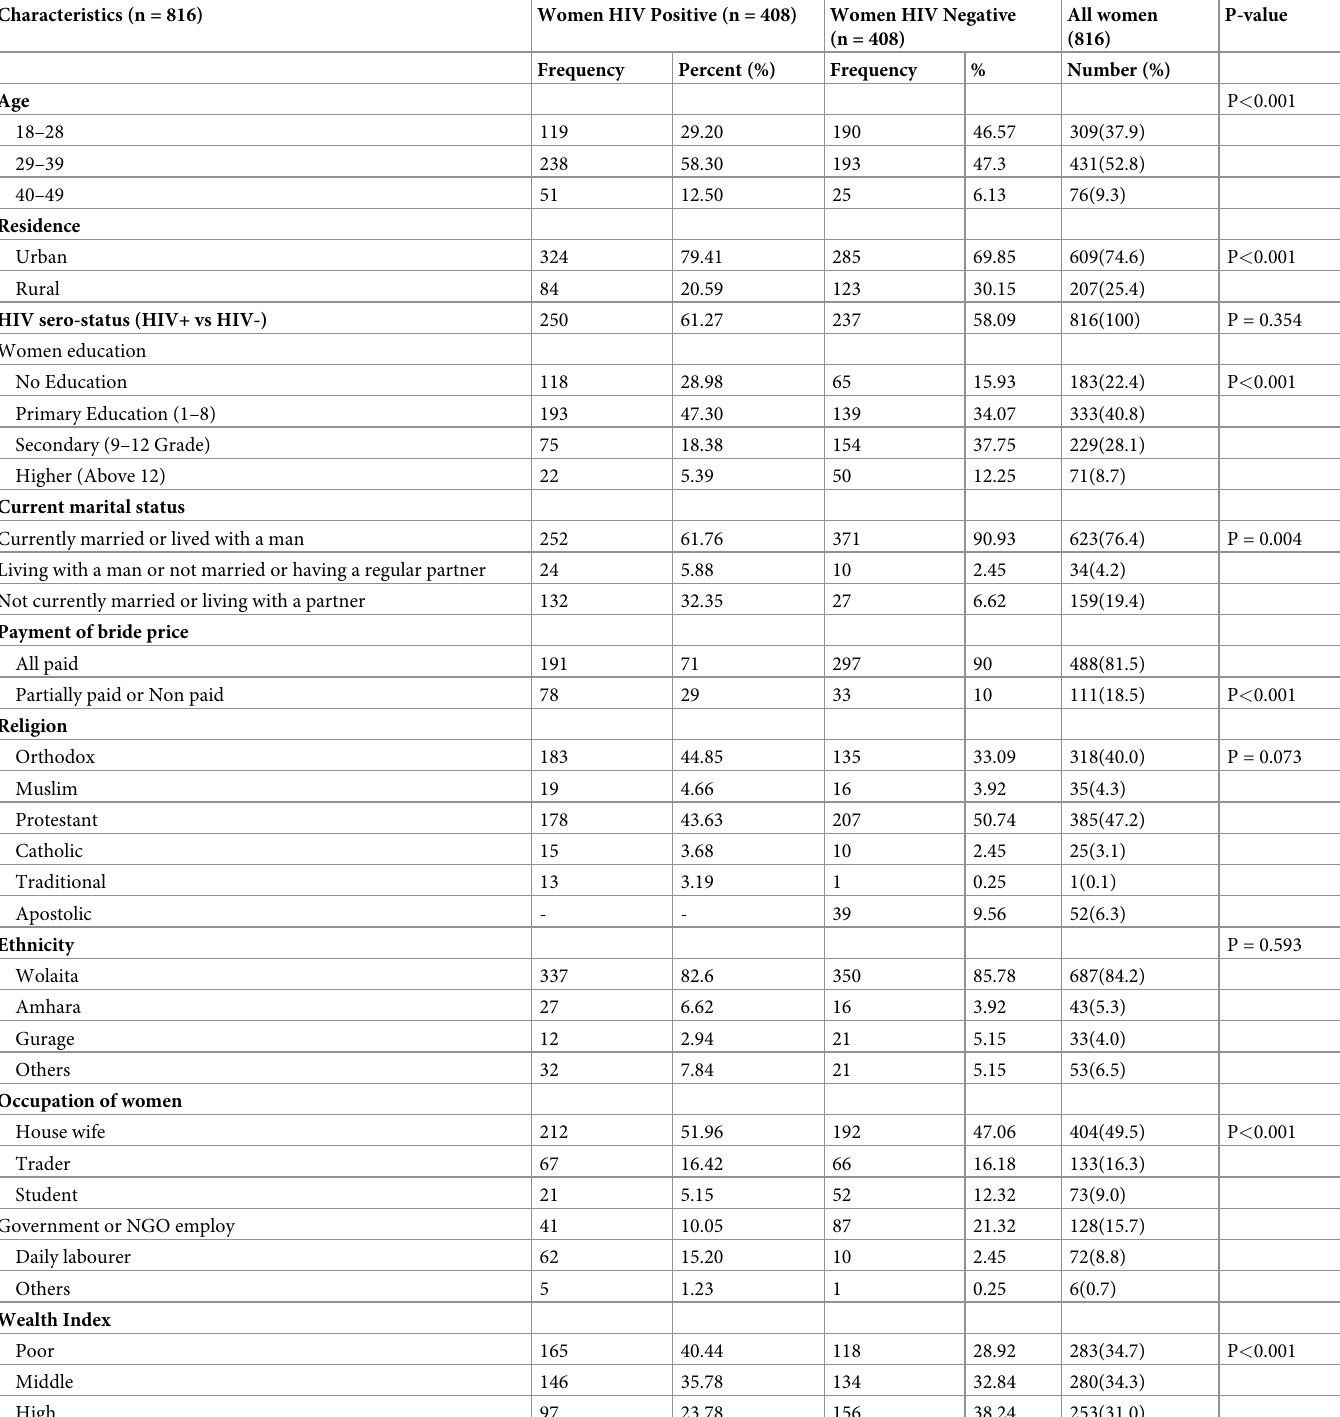
Table 1. Socio demographic characteristics of Women living with and without HIV in Wolaita Zone, Southern Ethiopia, from November-December 2018. Characteristics (n =